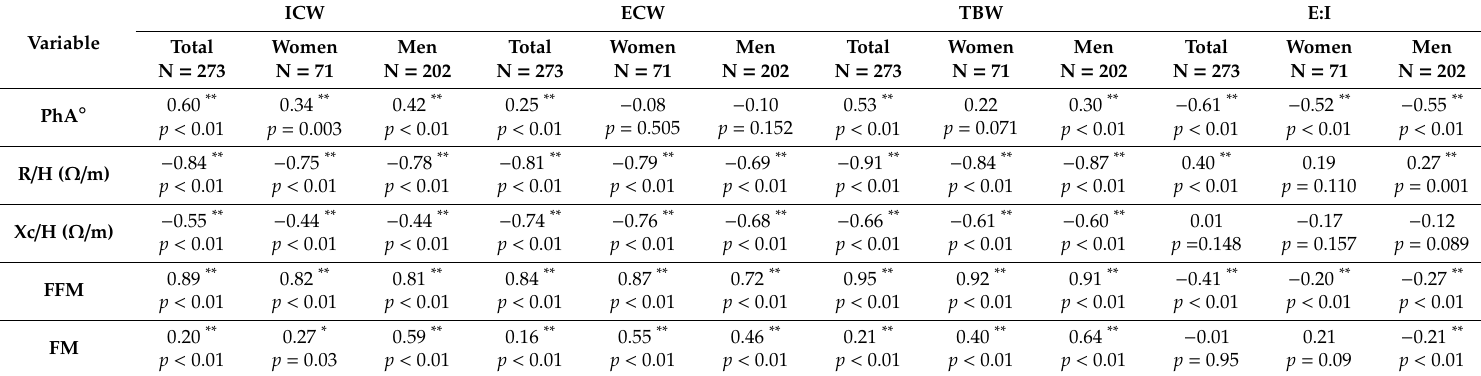
Table 2. Pearson correlation coe ffi cients (r) between raw bioelectrical impedance parameters and fluid volumes and